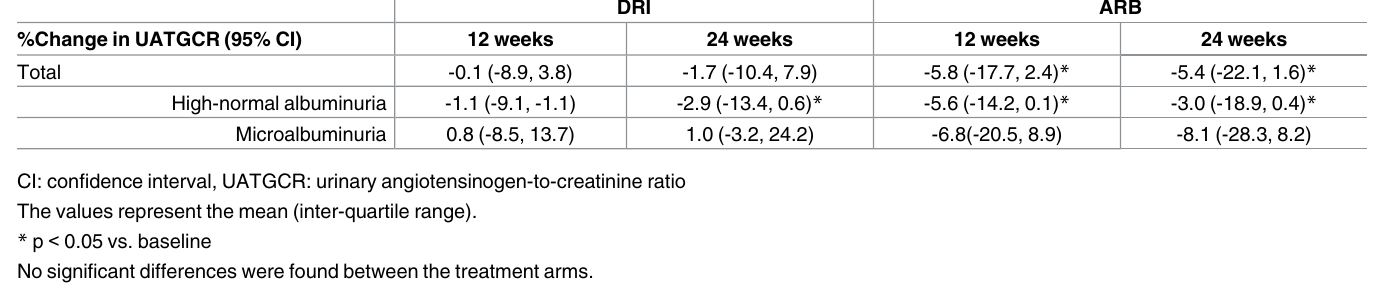
Table 4. Percentagechange in the urinary angiotensinogen-to -creatinine ratio.